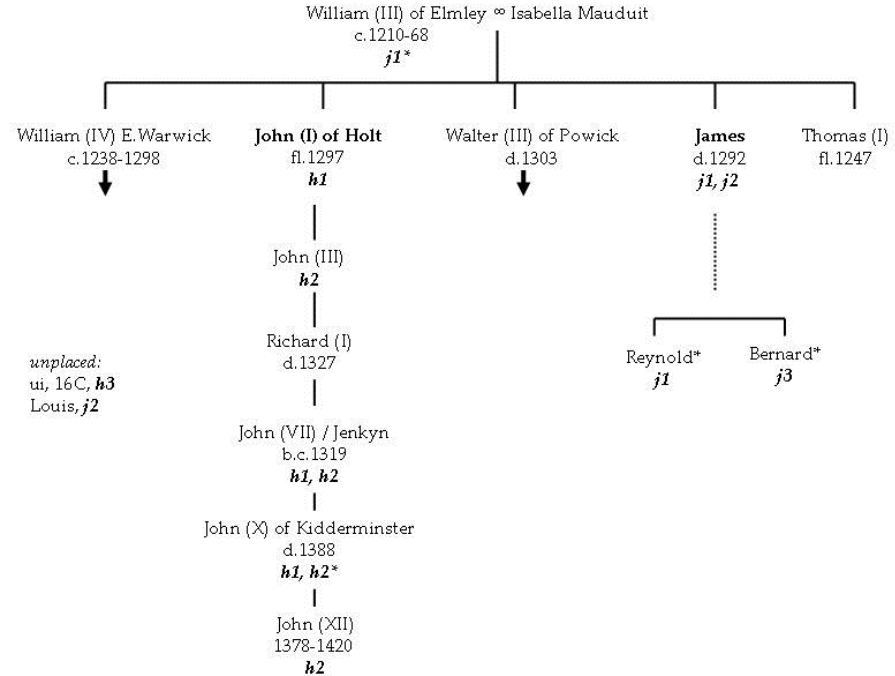
Figure 3. The branches of Beauchamp of Powick/Alcester, Bletsoe, and St. Amand. * problematic. assignment; e1–k1 arms as in Figure 1. o.s.p.: Died without children; o.v.p. In life of father.